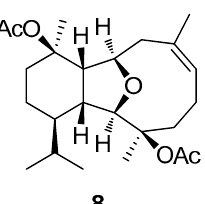
Figure 5. Diterpenoid ( 8 ) isolated by Rosa et al. from E. cavolini .